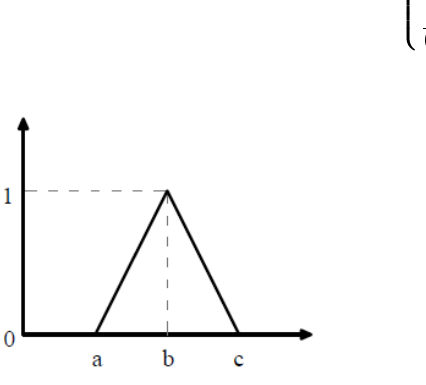
Figure 5. Triangular membership function.